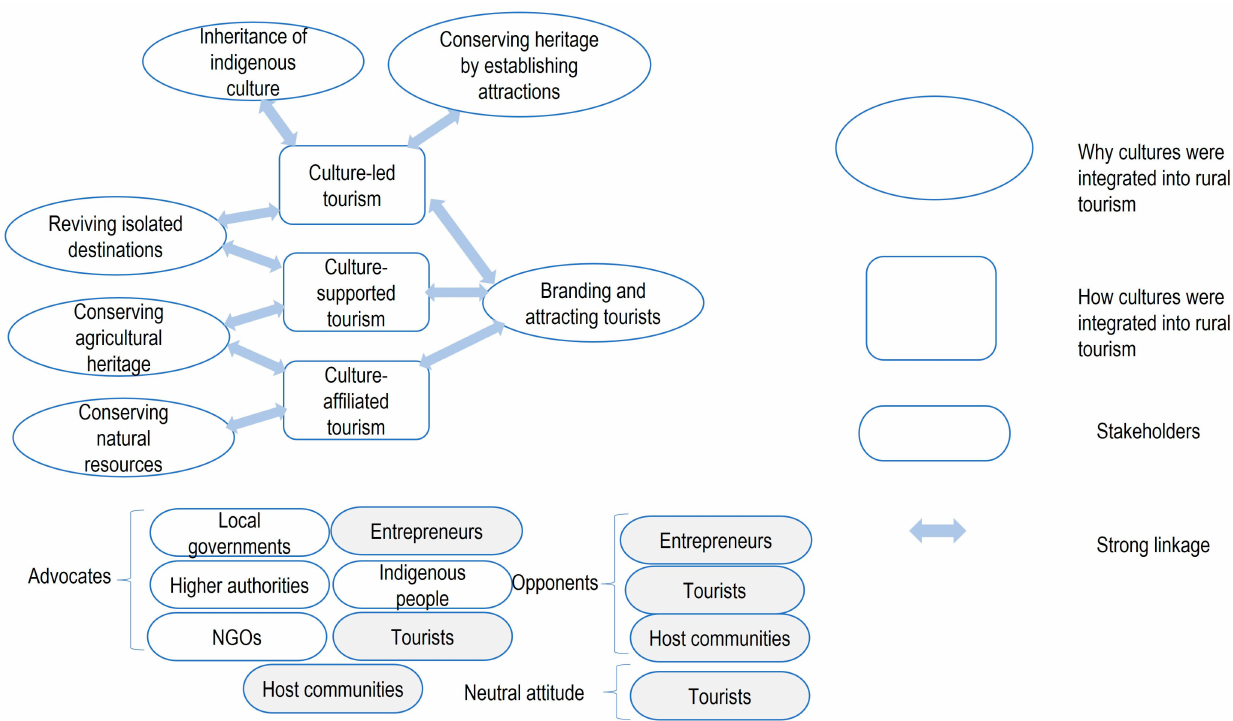
Figure 5. Synthesis of the scoping review results of cultural integration in rural tourism. Branding and attracting tourists are closely related to many types of